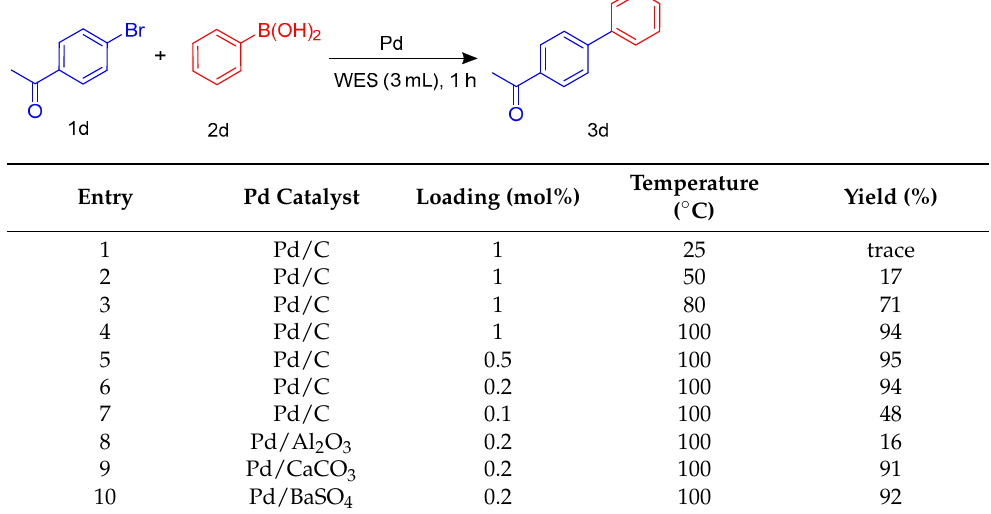
Molecules 2022 , 27 , x FOR PEER REVIEW